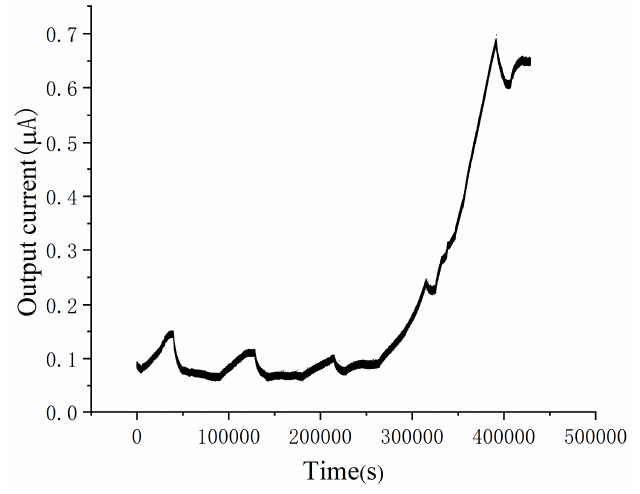
Figure 2. Start-up process for the microscale MFC biosensor, which takes approximately 5 days. A steady-state current of 0.65 μA is obtained after the start-up process.